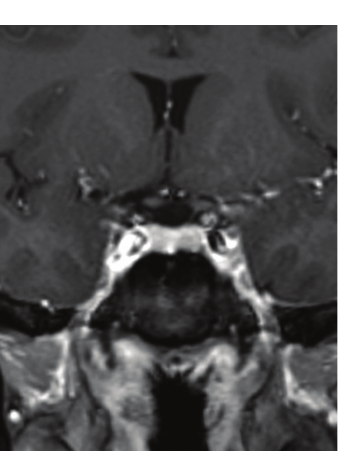
Figure 6: T1-weighted gadolinium-enhanced MRI performed 6 months after surgery showed no evidence of residual